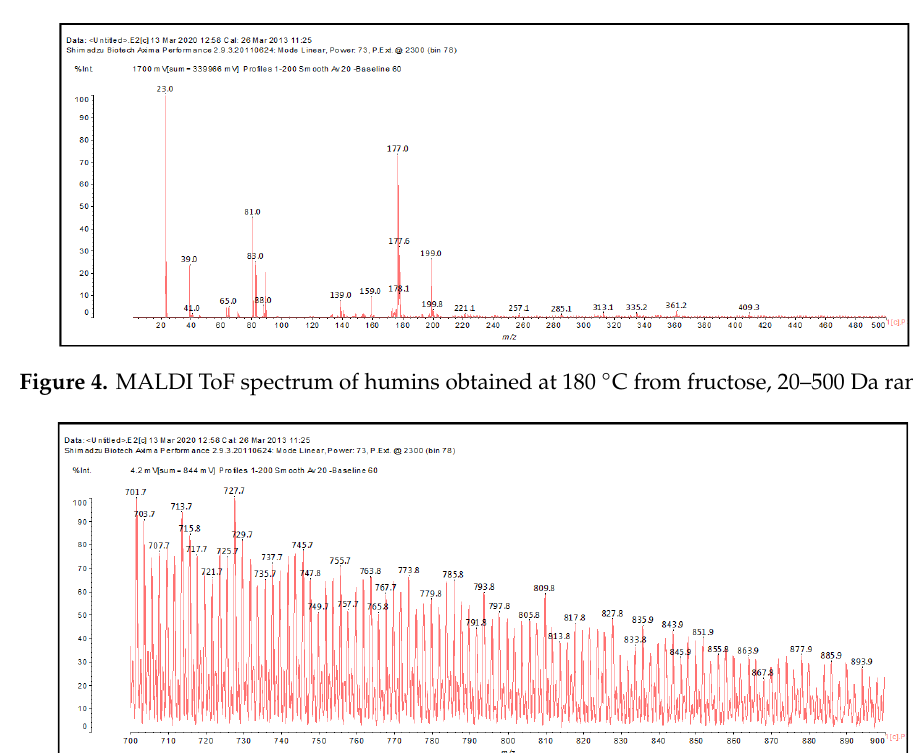
Figure 3. MALDI ToF spectrum of humins obtained at 150 °C from fructose, 500 – 1000 Da range. Polymers 2020 , 12 , x FOR PEER REVIEW